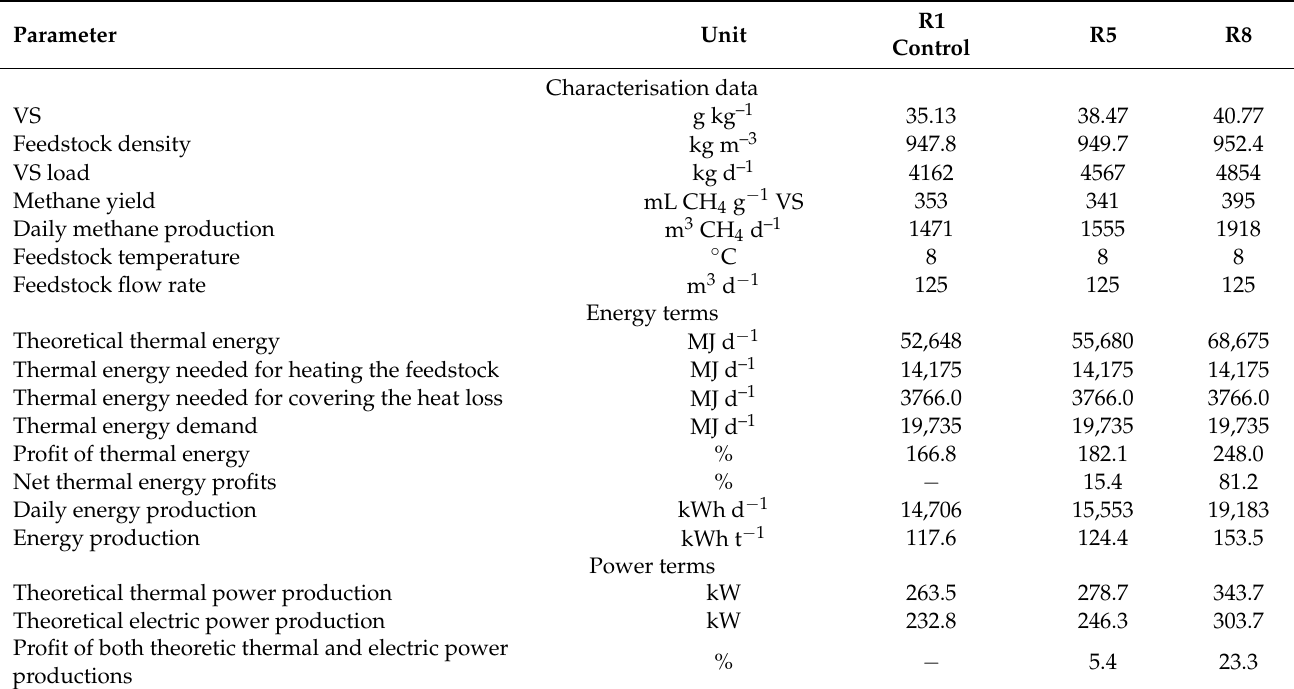
Table 5. The energy balance evaluation of selected